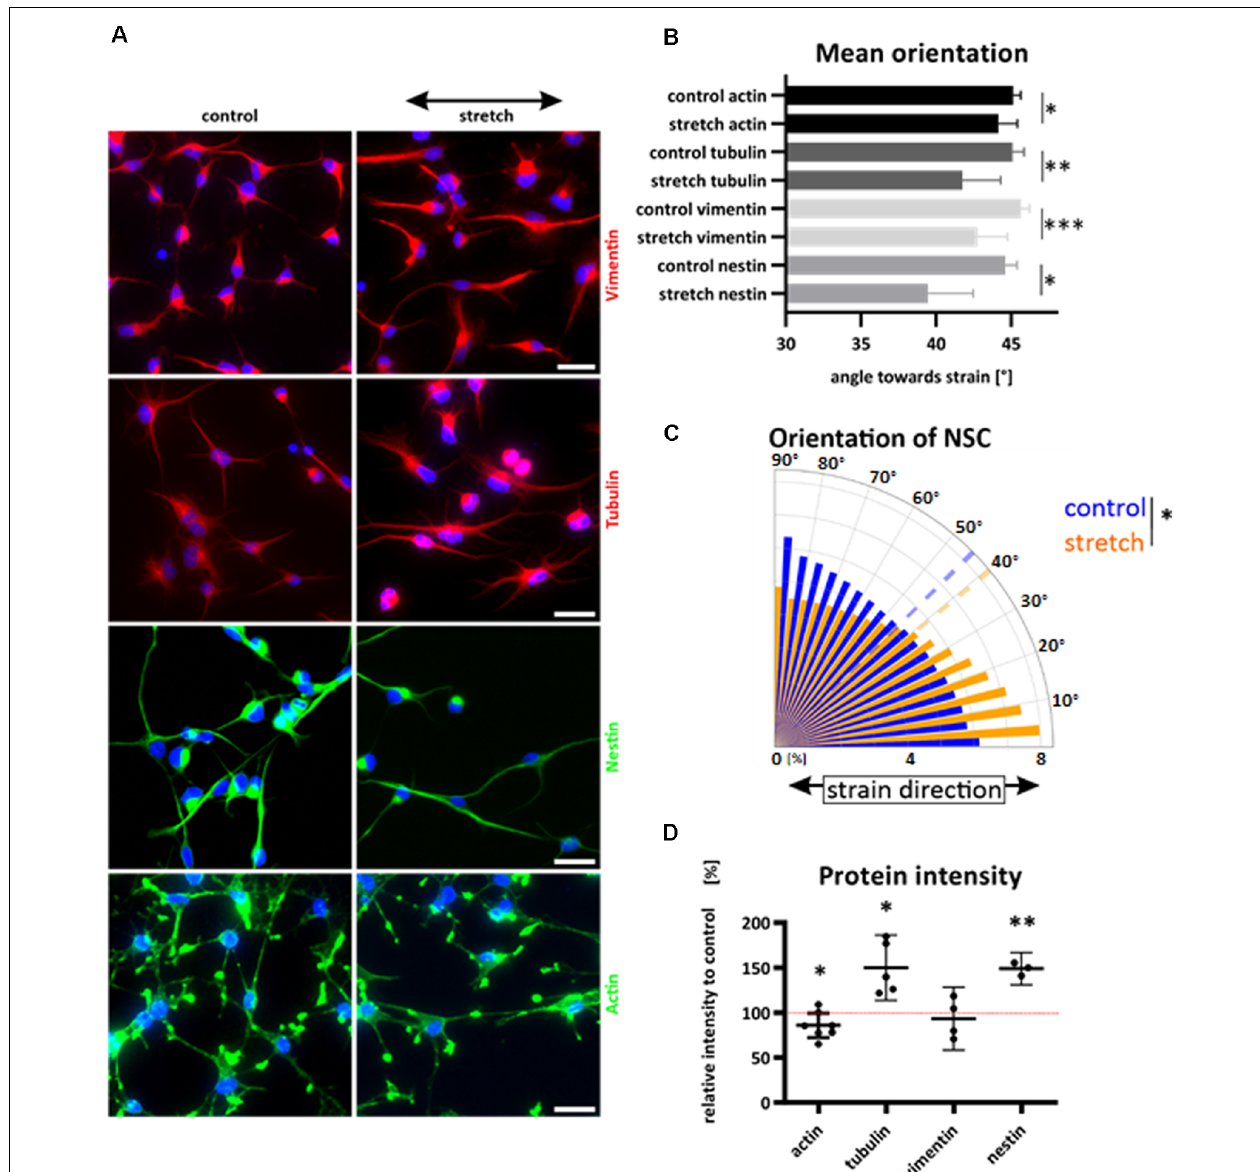
FIGURE 3 | Reorientation of NSCs under strain and cytoskeletal redistribution. NSCs were stretched for 24 h or grown on elastomer chambers as a control. Cells were fixed and cytoskeletal filaments were labeled (A) . The black arrow indicates the strain direction. Cyclic stretch induced a reorientation towards smaller angles and direction of strain (A–C) . Different cytoskeletal labeling resulted in different mean values of NSC orientation (B) , values represent at least n = 3 independent experiments with at least n = 5 chambers from two different passages. The orientation plot shows the frequency of pixels against nestin and their control relative to their orientation towards strain. The dashed lines show the mean angles (C) . Statistical significance was tested by comparing the mean angles of stretch and control ( p -value = 0.016; 39.5 ◦ vs. 44.6 ◦ ). Relative protein intensity after cyclic stretch (D) . Statistics show a one-sample t-test; the hypothetical value of 100% is indicated with a dotted red line. Actin showed a significant reduction under cyclic strain compared to control cells by 14% ( p -value = 0.0443).The intensity of tubulin increased by 50% ( p -value = 0.019 and nestin increased when stretched cyclically by 49% ( p -value = 0.007). Scale bars = 20 µ m. ∗ define significant differences (see “Material and Methods”